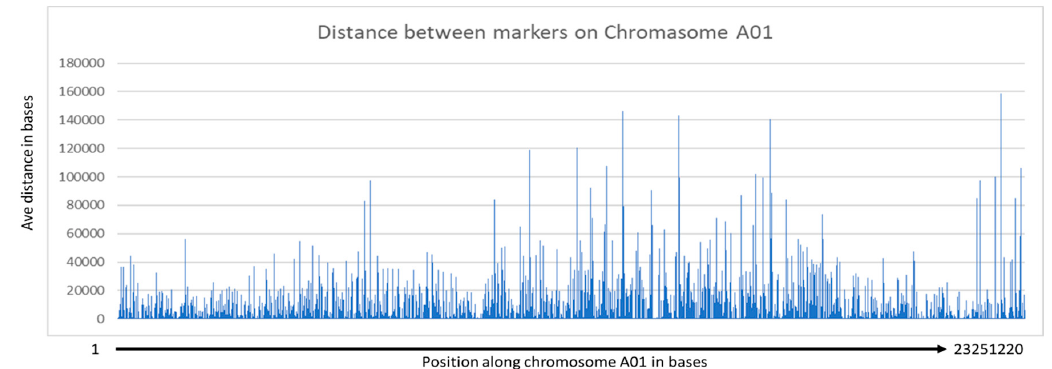
Figure 1. Distance between marker along chromosome A01.